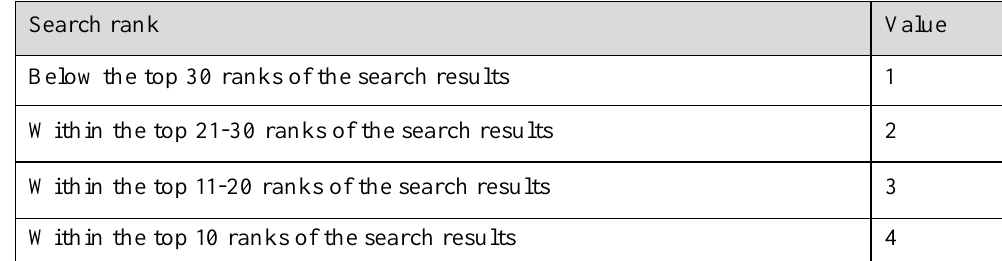
The Level of Relevance Based on Search Rank